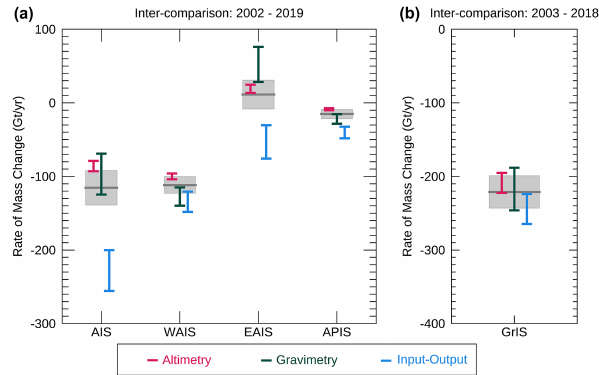
Figure 3. Inter-comparison of rates of ice sheet mass balance of (a) AIS, WAIS, EAIS, and APIS over the overlap period 2002–2019 and of (b) GrIS during the overlap period 2003–2018, as derived from the altimetry, gravimetry, and input–output techniques. The coloured bars represent the rates of mass balance and uncertainties in the aggregated technique time series, as calculated in Sect. 3 (ii). The grey box represents the rate of mass balance of our final rec- onciled assessment, which was calculated following the procedure detailed in Sect. 3 (iii). The horizontal line in the middle of the box shows the reconciled rate of the mass balance, and the height of the box represents its associated uncertainty.